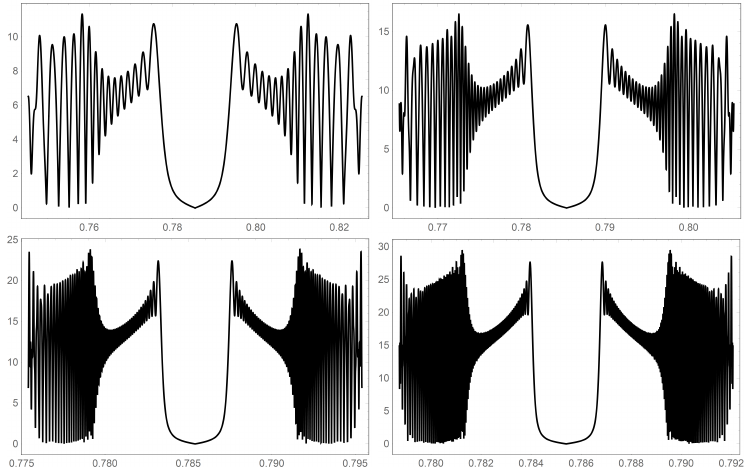
Figure 16. The scaling behavior with N of lacunary trigonometric system obtained from | L ( C ( 4 ) ; z ) | by setting z = e i φ . The four panels show the region around the first symmetry zero ( π Quasi-self-similarity is seen as N changes: top left, N = 50; top right, N = 100; bottom left, N = 200, bottom right, N = 300. The domain size scales as 1/ N